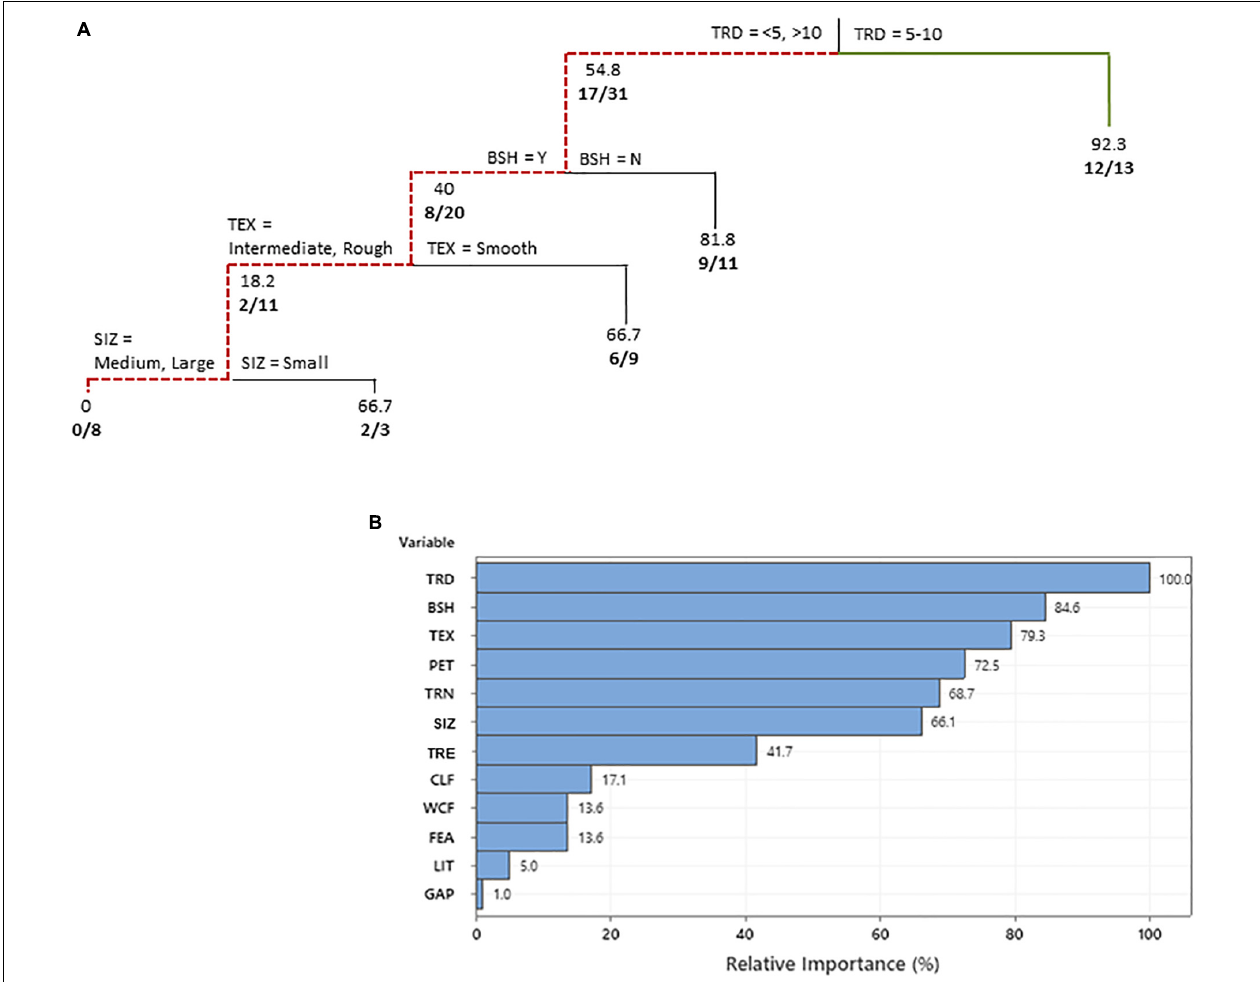
FIGURE 4 | Classification tree (A) predicting the swimming pool characteristics that influenced bats observed drinking at the pools of residents in a suburban neighborhood in Fort Worth, TX, United States. The variable predictors that create a split are labeled at each branch split. Below each node values represent the percentage of responses in which bats were observed and number of positive responses along with the total number of responses considered are given in bold. A bold solid green line shows the combination of independent variables that led to the most observations and a red dotted line shows the variables resulting in the least observations. Relative variable importance chart (B) with relative importance defined as% improvement with respect to the top predictor. TRD, distance (m) of trees from pool; BSH, bushes/shrubs and structures ( < 2 m) close to or bordering pool; TEX, pool interior texture; TRN, number of trees visible from the pool; SIZ, surface area of swimming pool m 2 ; TRE, pool treatment; CLF, how often is pool cleaned; WCF, walled edge/cliff/fence present; FEA, connected hot tub/fountain/waterfall feature present; LIT, pool lighting; and GAP, distance of gap between tree